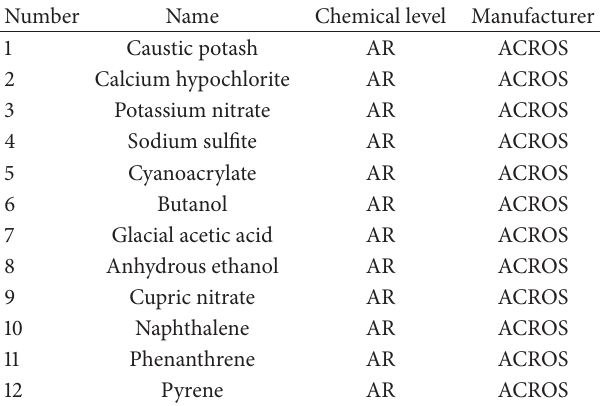
Table 1: Main reagents and their